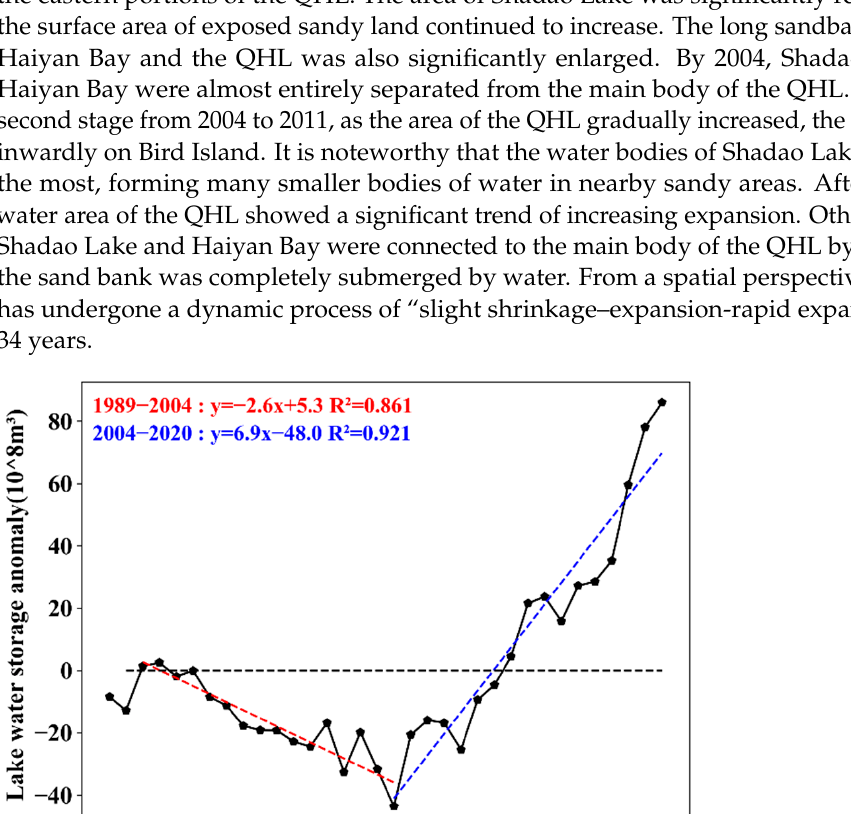
Figure 4. The time series change of the QHL storage anomaly from 1987 to 2020.